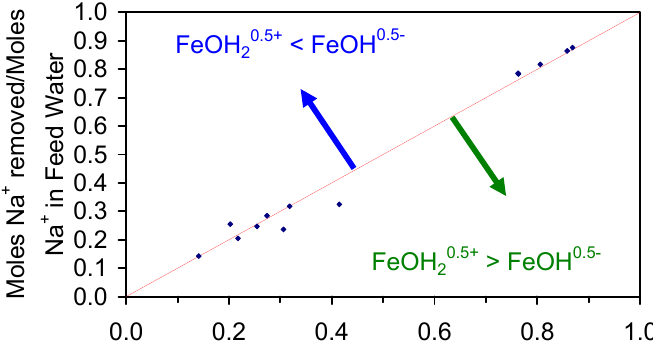
Figure 7. Relative removal ratios associated with Cl − and Na + ions in saline